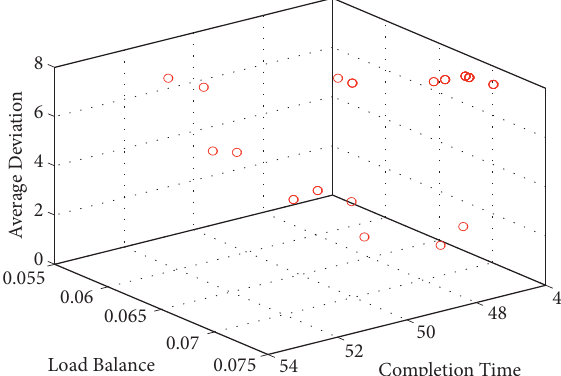
Figure 6: Nondominated graph optimization for rescheduling tasks at t �